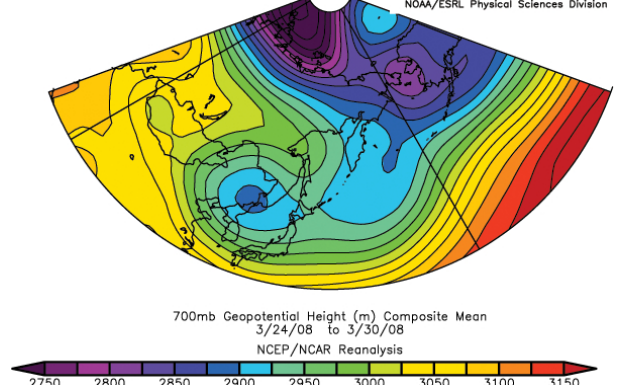
Fig. 11. Mean 700hPa geopotential height (m) pattern, 24–30 March 2008. This represents rough synoptic flow paths leading up to the “Arctic Haze” period. Locations of the Norilsk region of Northern Russia (white dot) and the Fairbanks area (white triangle) are